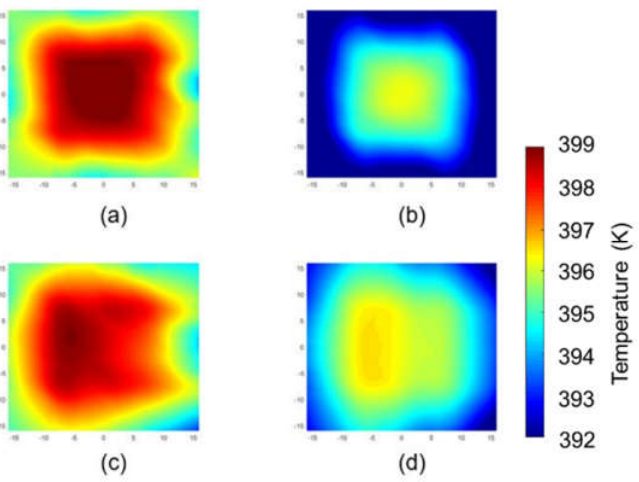
Figure 13. Temperature contour comparison among the “Outlet” conditions: ( a ) “SS”; ( b ) “PS”; ( c ) “SC”; ( d ) “PC”. ( c ) “SC”; ( d ) “PC”.